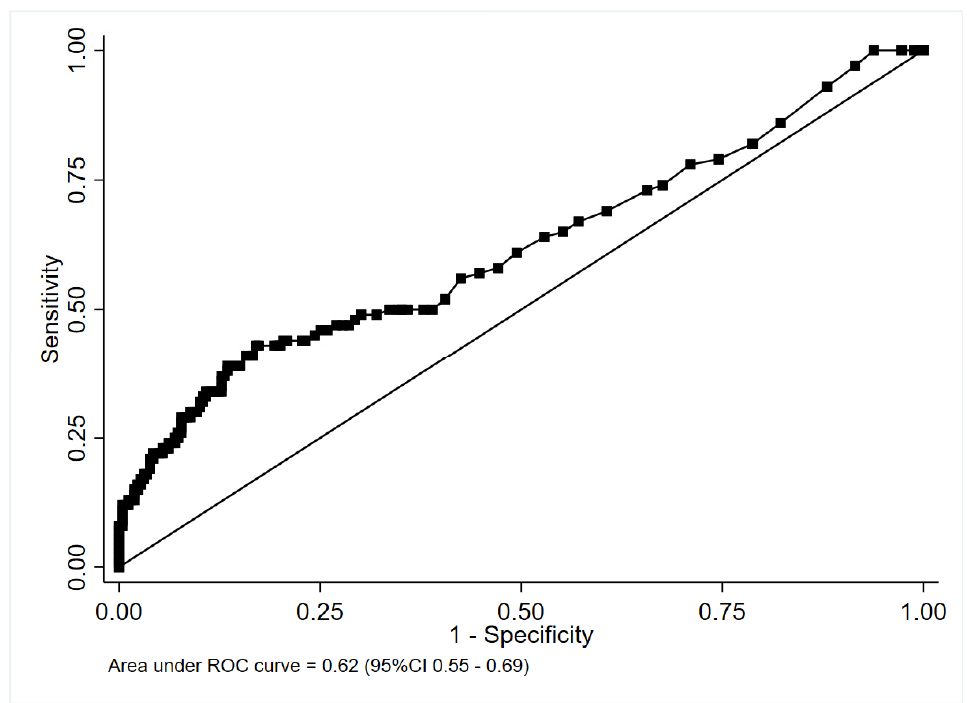
Figure 3. Receiver-operating characteristic curve of serum procalcitonin for the diagnosis of clinical bacterial pneumonia.